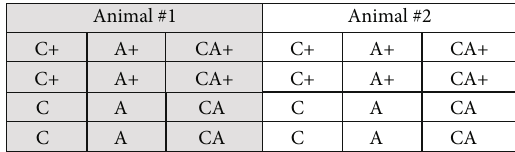
Figure 1: Layout of a tissue culture plate. A total of 8 plates were used, 2 animals per plate, for an “ n ” of 16 animals. C =cartilage explant; A =adipose tissue explant; +=inclusion of LPS (10 μ